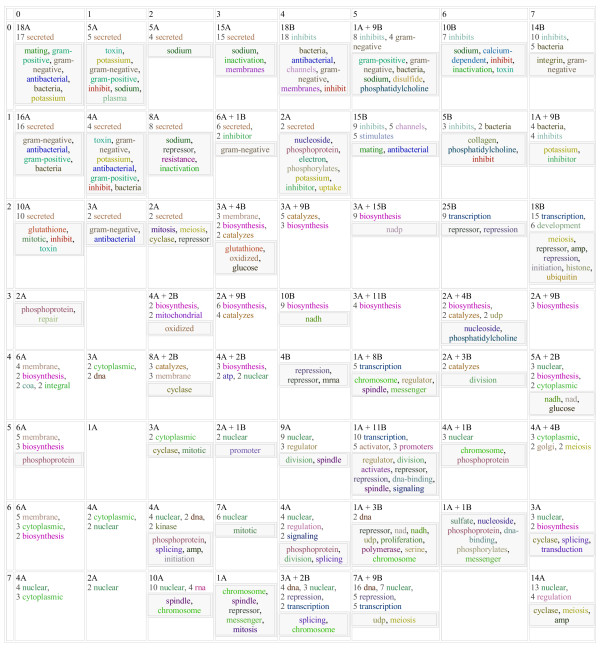
Predictor map. A total of 500 sequence-to-function predictors were produced by the self-supervised genetic programming approach. In this figure, an 8 × 8 Self-Organizing Map (SOM) is used to cluster the predictors based on the pattern of sequence-based test set classifications. Predictors which classify similar subsets of the sequences will be localised to the same region of the map. Each SOM node is annotated as follows (the example used is at row 3 column 2): the number of "A-type" and "B-type" predictors which map to this node (e.g. "4A + 2B"); the common target words for the annotation-based classifier and their frequencies (e.g. "2 biosynthesis, 2 mitochondrial"); the inset boxes show which annotation words are over-represented in the test set sequences which are positively classified by the sequence-based classifier (e.g. "oxidised"). See Methods for detailed information.